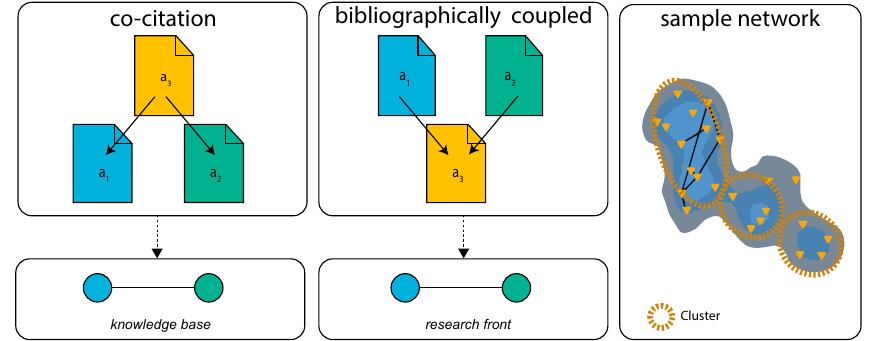
Figure 2. Knowledge Base, Research Front, and Sample